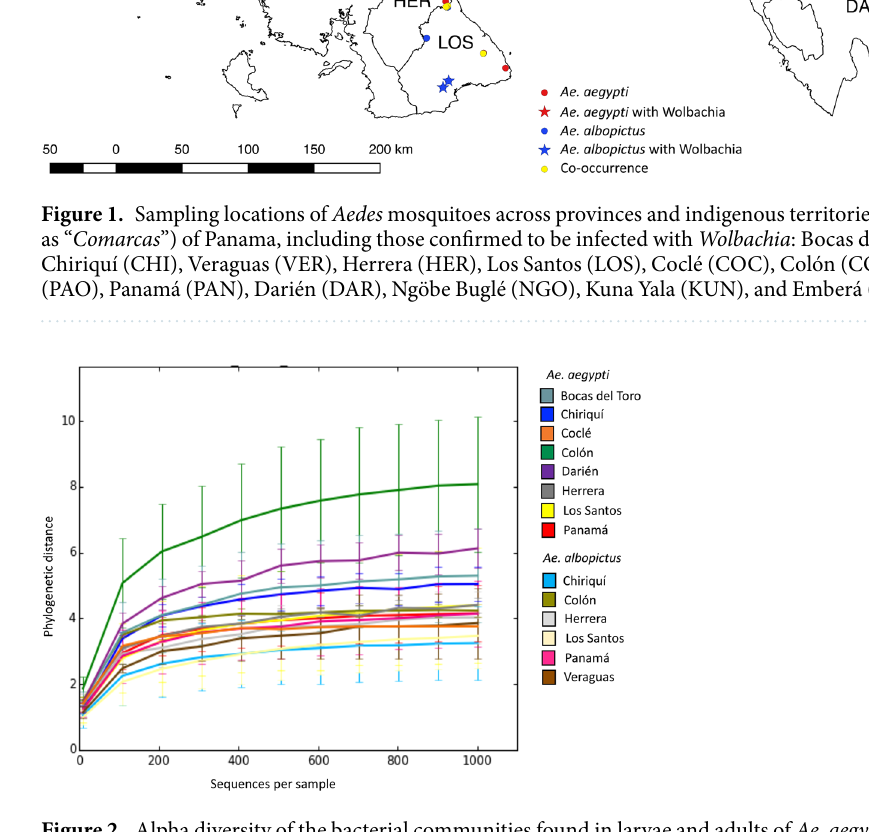
Figure 2. Alpha diversity of the bacterial communities found in larvae and adults of Ae . aegypti and Ae . albopictus collected from human inhabited environments across Panama as distinguished by the province from which they were collected. Mean Faith’s phylogenetic diversity ( ± SE) of each sample group is shown across different sequencing